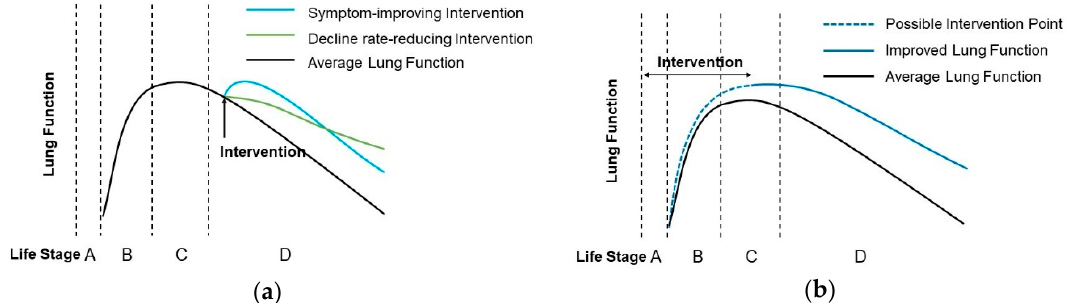
Figure 1. Hypothetic model for the effect of dietary interventions on lung function over the lifespan. ( a ) Symptom-improving intervention and decline rate-reducing intervention patterns by dietary nutrients or phytochemicals in the older life stage; ( b ) A conceptual model about nutrient intervention by life stage before lung function peak for lung function preservation over the lifespan. Life stage A: the maternal and prenatal period; B: childhood; C: young adulthood; D: older life.